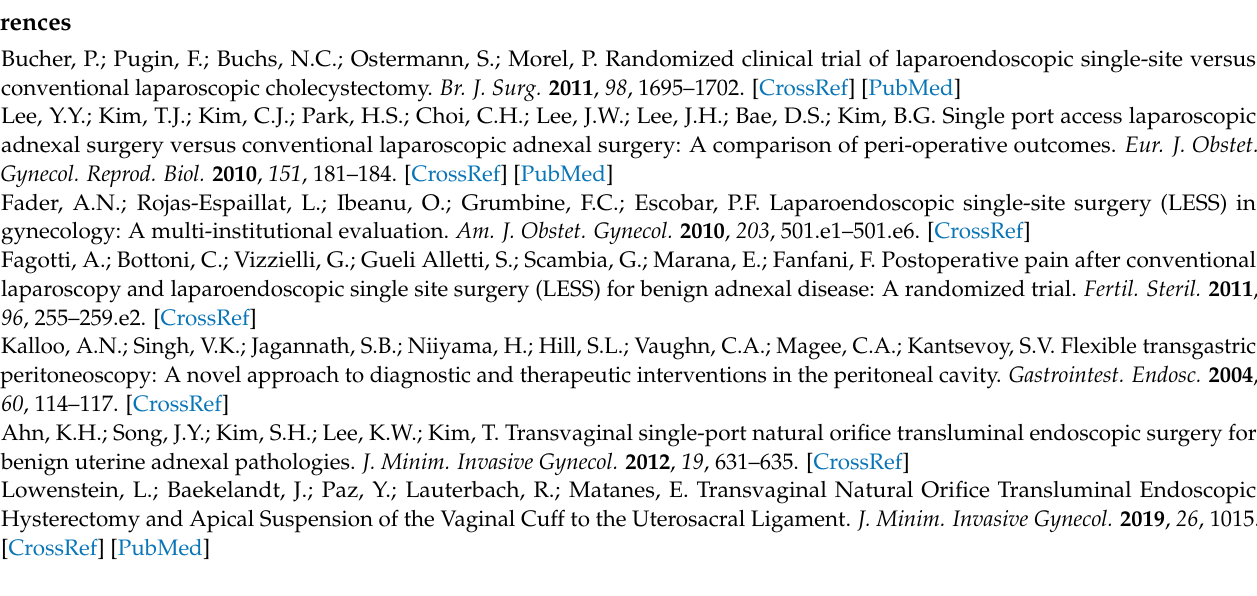
Figure 3. Image of the right ureter during vNOTES hysterectomy ( A ) when the uterus was still attached and ( B ) when the uterus was completely removed.